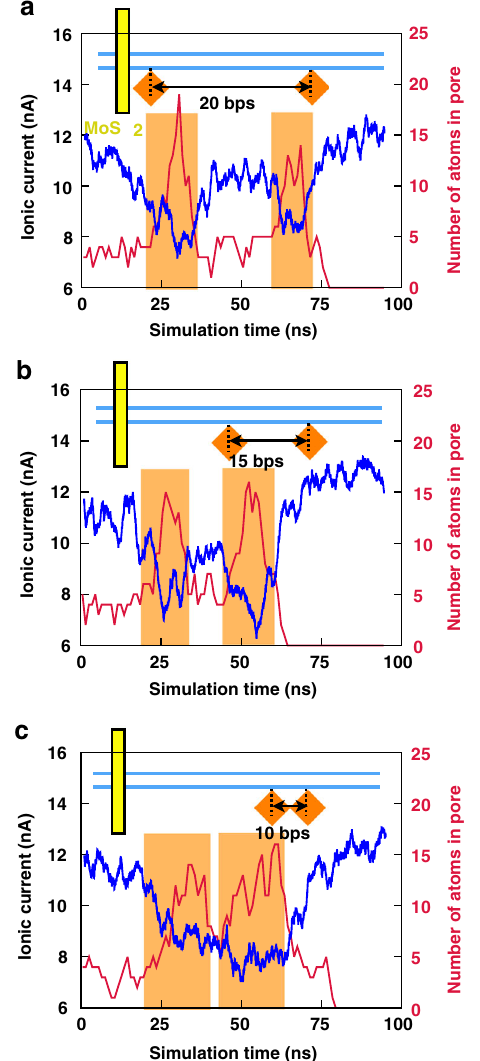
Fig. 5 Resolution of methylation detection using ionic current across a MoS 2 nanopore. a – c Recorded ionic current and DNA/ protein atom number in the pore during the translocation of mDNA- MBD1 complexes containing two methylation sites separated by a 20, b 15, and c 10 bps